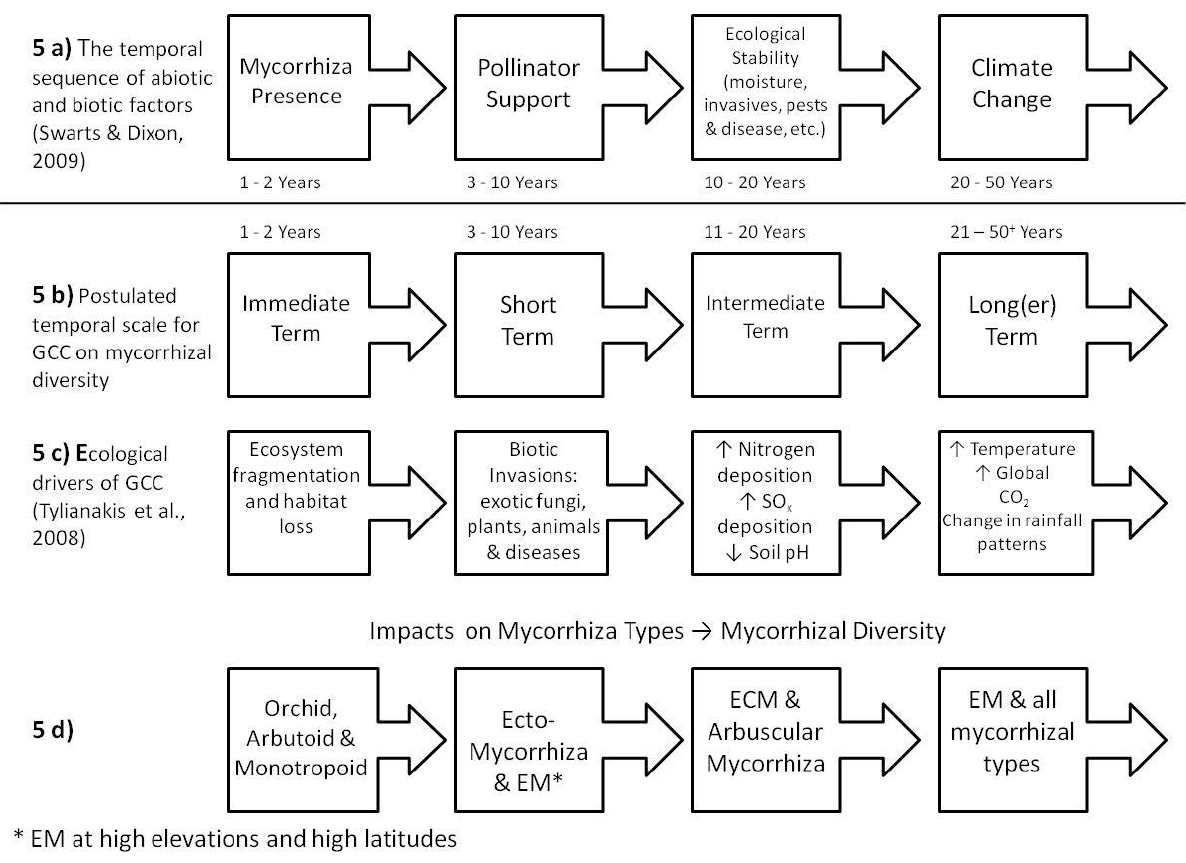
Figure 5. Impacts of different GCC temporal scenarios on mycorrhizal diversity (Swarts & Dixon [124]; Tylianakis et al.